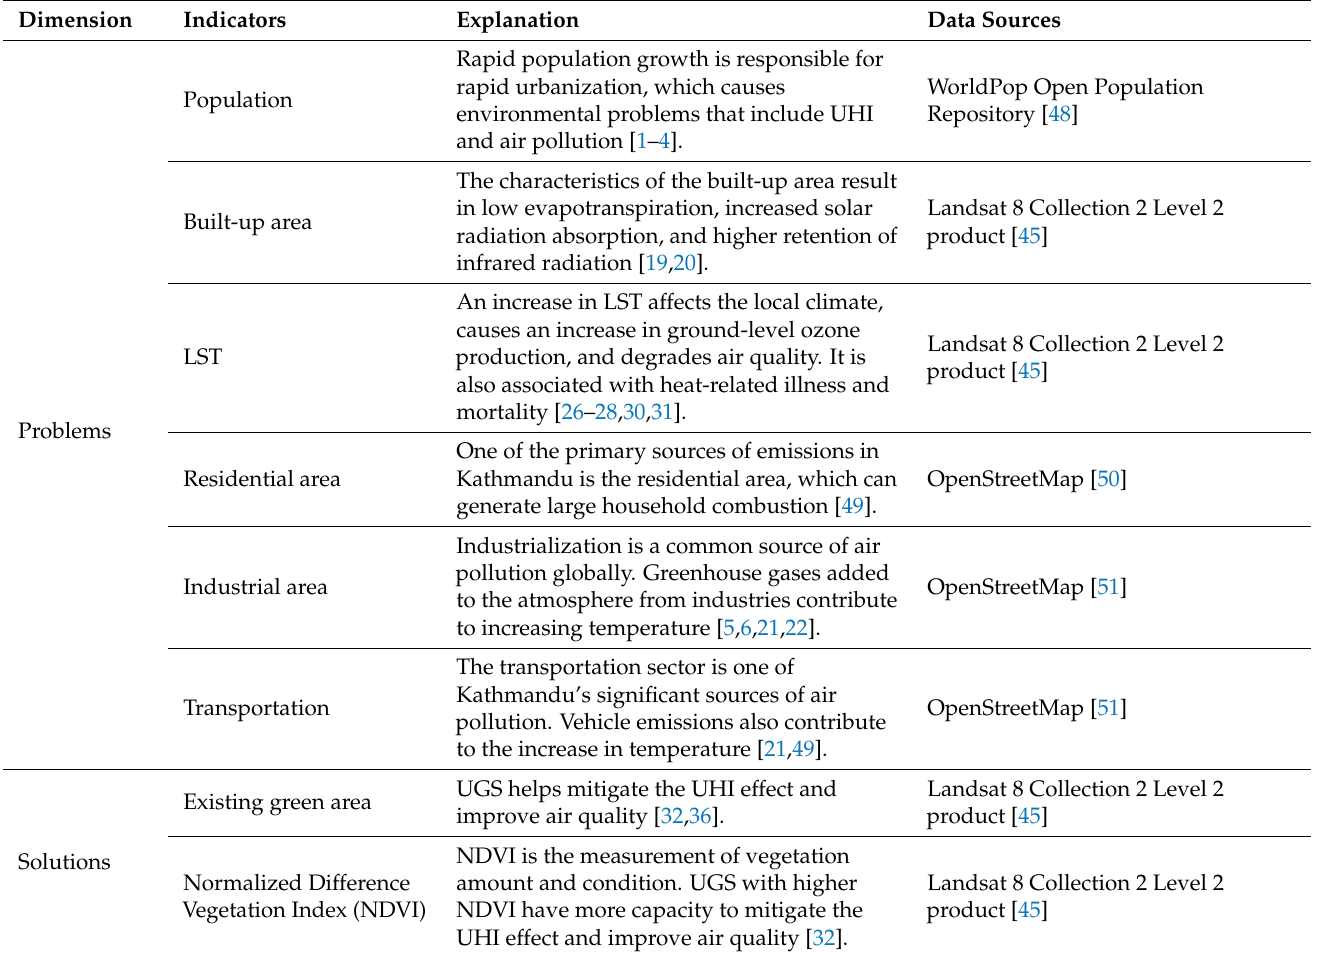
Table 1. Indicators of Composite Index for UGS establishment to mitigate the UHI effect and air